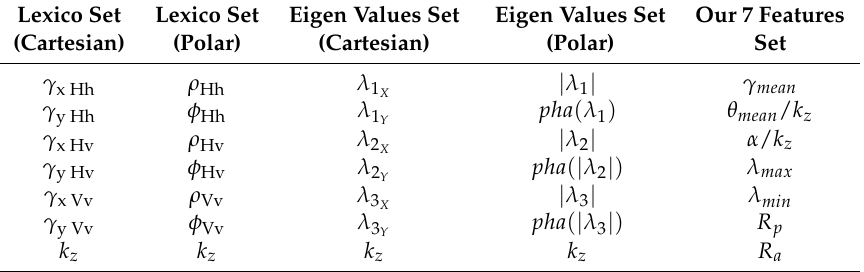
Table 2. The different training